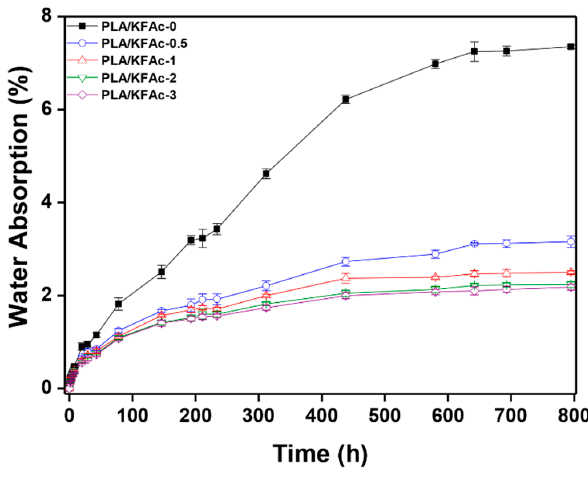
Figure 10. Water uptake of all composites as a function of immersion time.